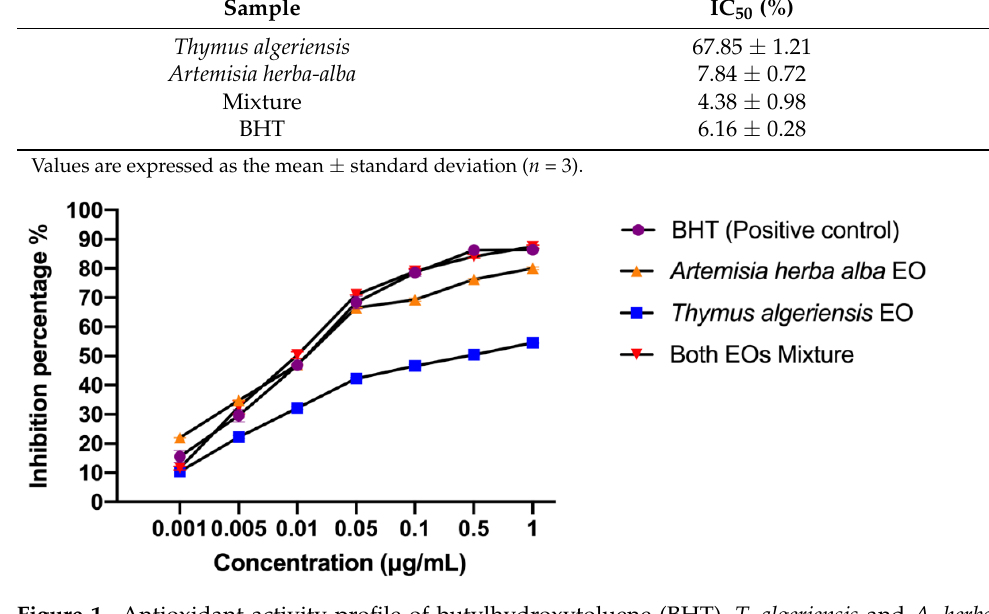
Figure 1. Antioxidant activity profile of butylhydroxytoluene (BHT), T. algeriensis and A. herba-alba essential oils and their mixture (50:50) in the DPPH test. The values are expressed as the mean ± standard error of the mean with n = 3.